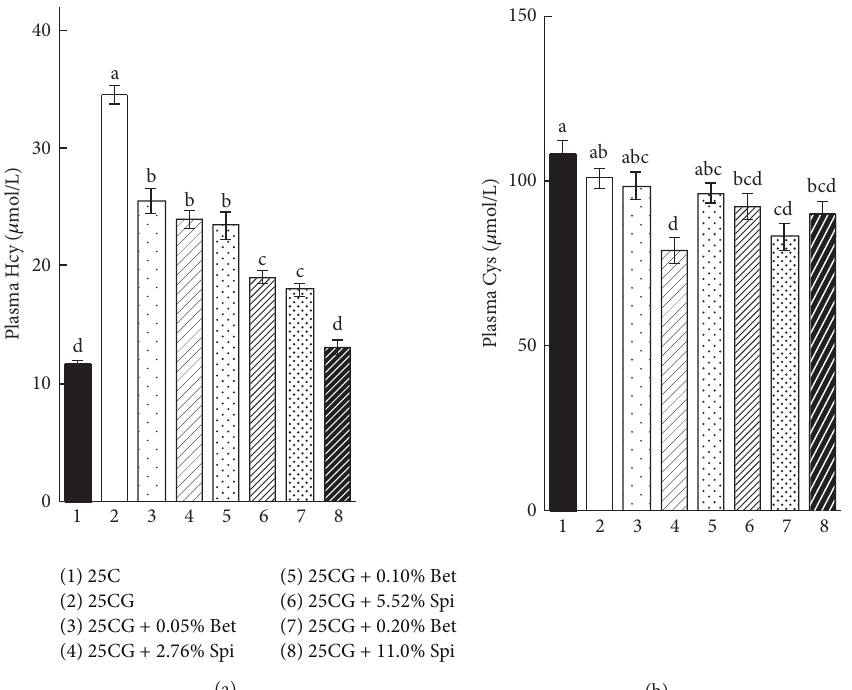
Figure 2: Plasma homocysteine (a) and cysteine (b) concentrations in rats fed the experimental diets (experiment 1). Each value is the mean ± SEM, 𝑛 = 8 . Values in a panel without a common letter differ at 𝑃 < 0.05 . 25C, 25% casein diet; 25CG, 25C + 0.5% guanidinoacetic acid; Bet, betaine; Cys, cysteine; Hcy, homocysteine; Spi, spinach